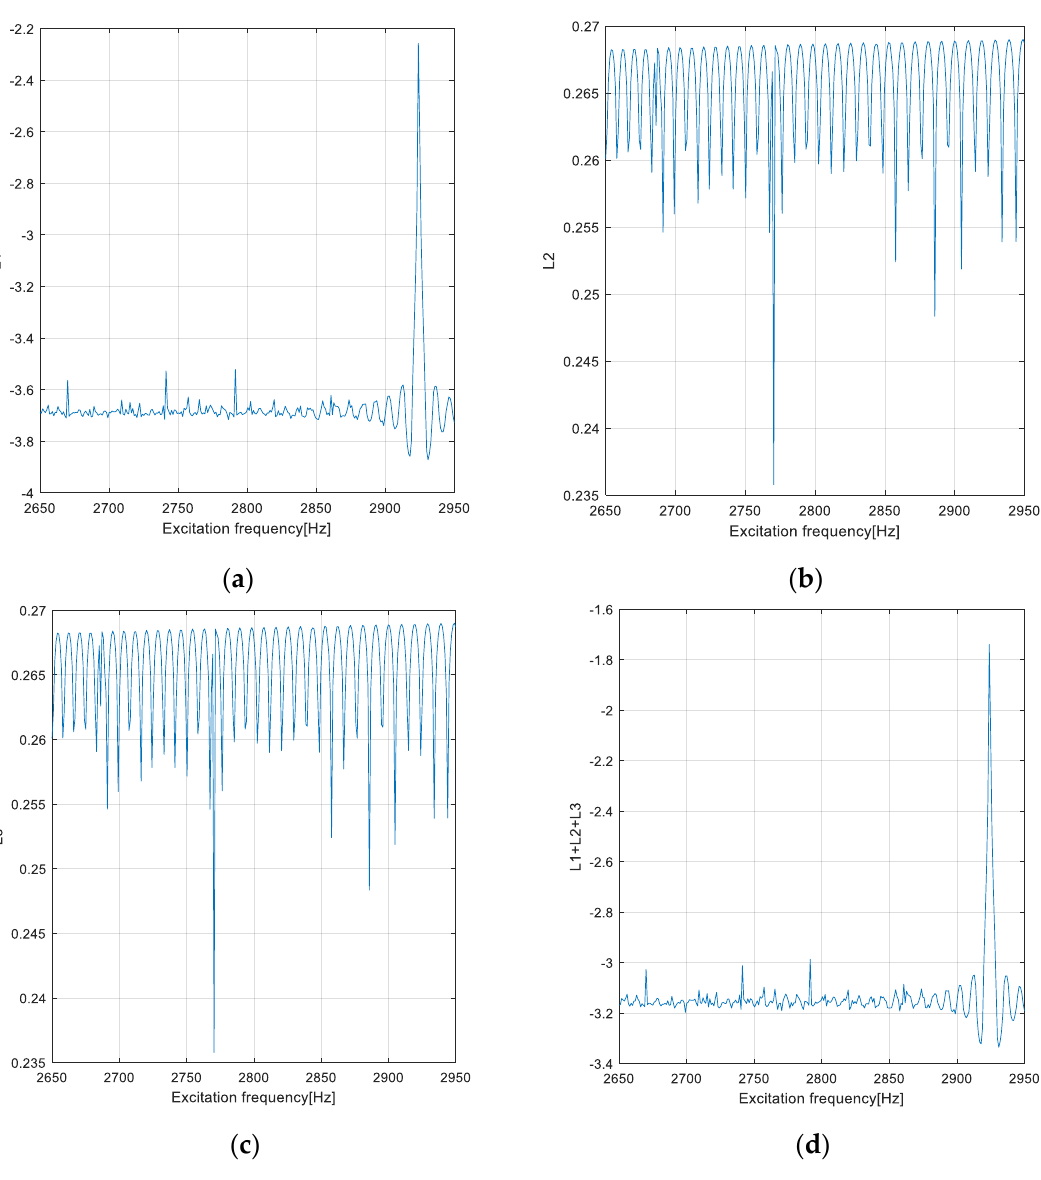
Figure 21. Lyapunov exponents of NFTV for DOE3, β 2 = 9 0 , ξ = 1.6 · 10 − 3 . As can be seen from the Figures 21–24 in (a) is presented the graph variation of the Lyapunov exponent L 13 (see Equation (34), to verify the criteria (37)), in (b) is illustrated the graph variation of the Lyapunov exponent L 23 ( see Equation (35), to verify the criteria (37)), in (c) is shown the graph variation of the Lyapunov exponent L 33 ( see Equation (36), to verify the criteria (37)), and in (d) is presented the graph variation of the sum of Lyapunov exponents L 13 + L 23 + L 33 (in order to apply the criteria (39)), for the nonstationary FTV of DOE3 in transition through the PPRR, namely for excitation frequency in the range [2650,2950]